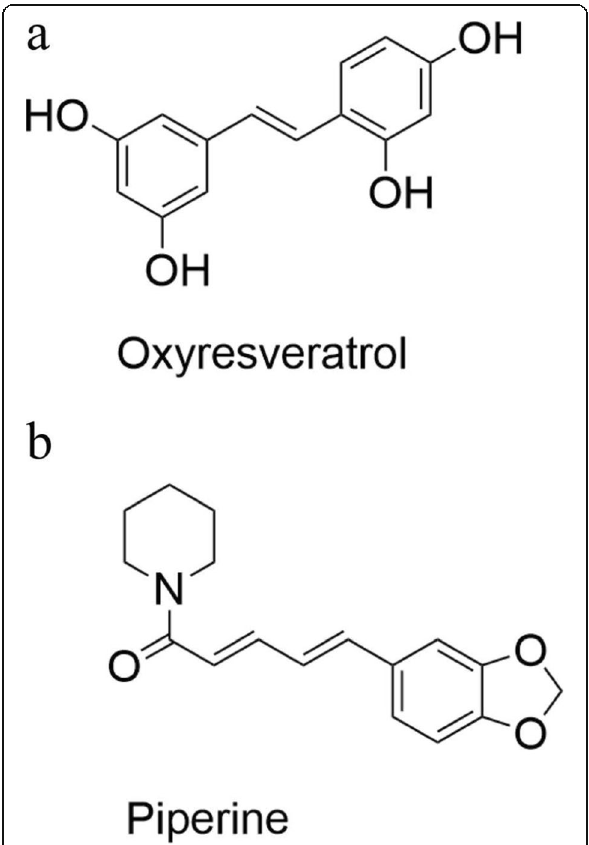
Fig. 1 Chemical structures of Oxyresveratrol ( a ); Piperine ( b